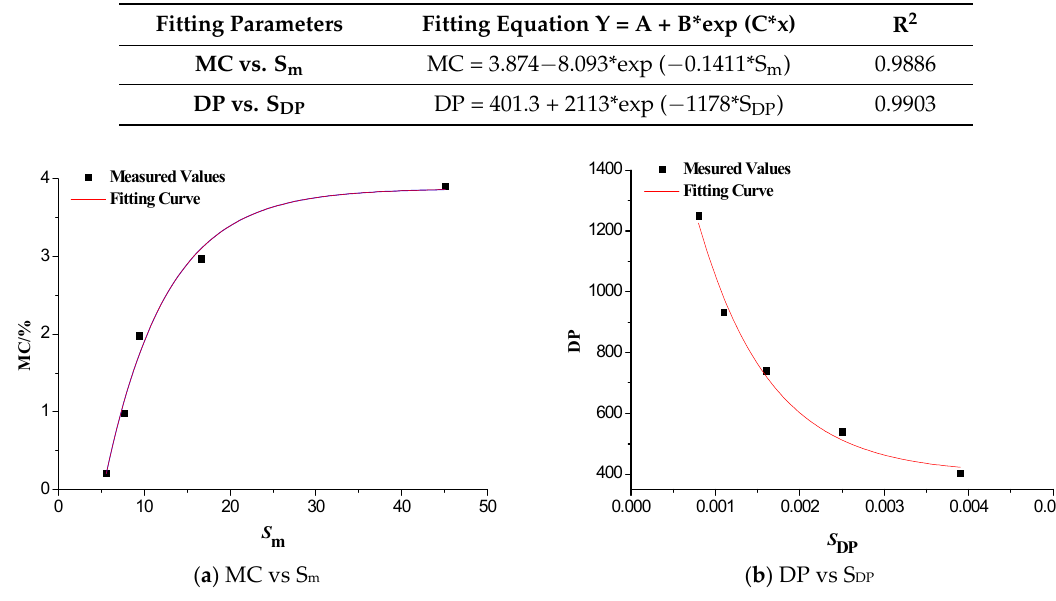
Table 3. The fitting Equation of S m and S DP .